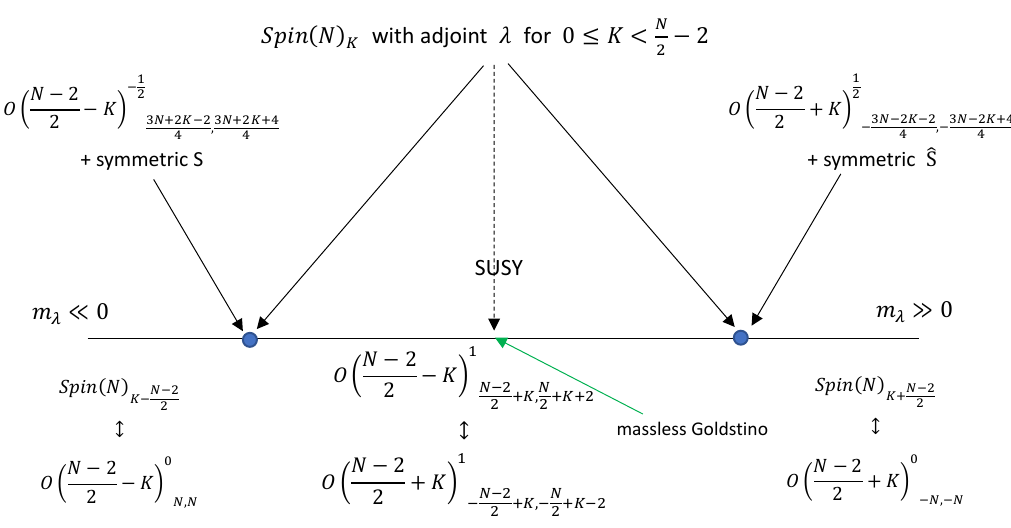
Figure 2: The phase diagram of Spin ( N ) gauge theory coupled to an adjoint fermion. The infrared TQFTs, together with relevant level-rank duals are shown along the bot- tom. The blue dots indicate transitions from the semiclassical phase to a quantum phase. Each transition is weakly coupled in a dual theory, which covers part of the phase diagram. The dual theory has symmetric tensor fermions ( S and (cid:98) S ). Across these transitions the superscript level of the TQFT jumps, i.e. O ( N ) 0 and O ( N ) 1 are exchanged. The fractional levels represent the effective contributions from the mass- less fermions. At a special value of the mass in the quantum phase, the ultraviolet theory is supersymmetric. This symmetry is spontaneously broken leading to a mass- less Goldstino [ 37 ] . This phase diagram is obtained from that of the SO ( N ) theory proposed in [ 6 ] , by tracking the global symmetries and counterterms and then gaug-